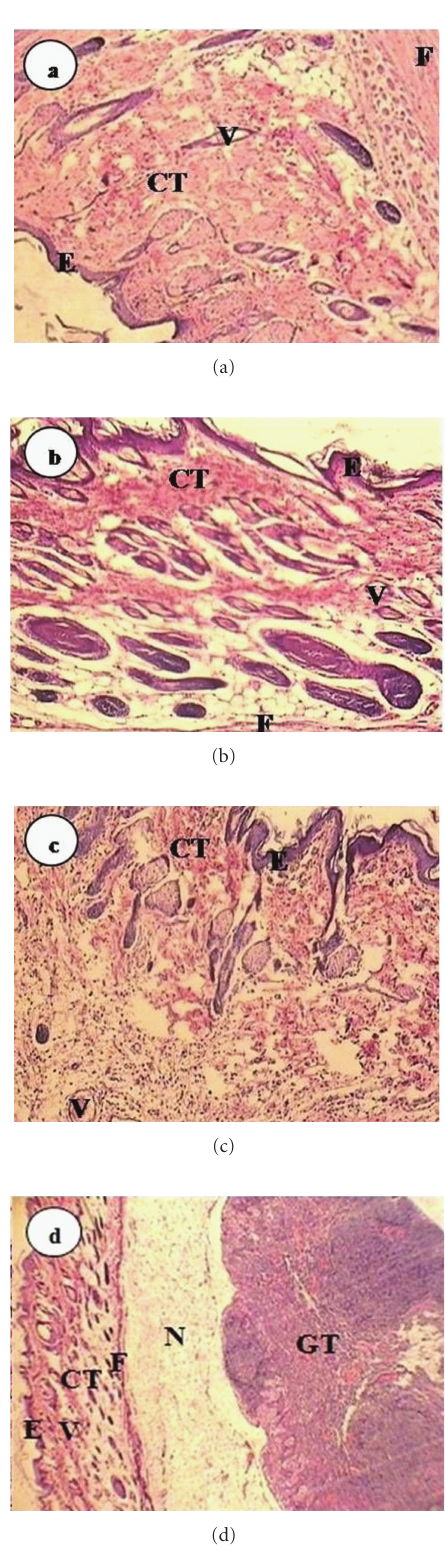
Figure 1: The photomicrographs of rat subcutaneous connective tissue reaction with × 100 magnification. (a) Grade 0 (b) Grade I (c) Grade II (d) Grade III. e: Epiderm, CT: connective tissue, CC: chronic inflammatory cell, GT: granulation tissue, F: fibrosis, N: necrosis, V: